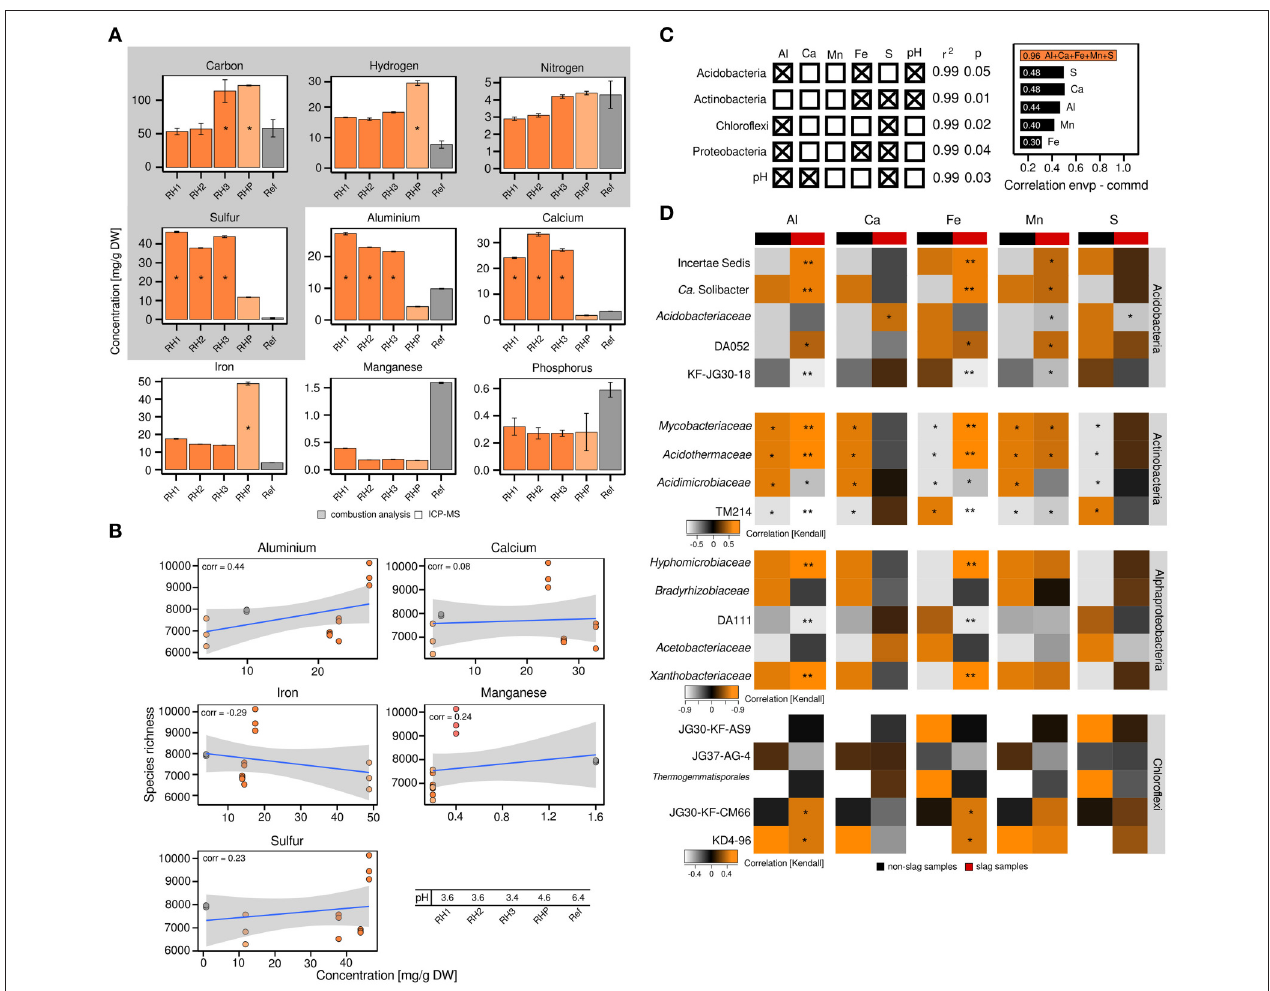
FIGURE 2 | Correlation analyses between the abundance of particular bacterial taxa and elements. Detection and quantitation of the examined elements involved combustion analysis and inductively coupled plasma mass spectrometry, *significant enrichment ( p ≤ 0.05) based on one-way ANOVA, DW = dry weight (A) . Correlation analysis between bacterial species richness and particular elements based on Pearson correlation coefficients (corr = correlation) (B) . Multiple regression analysis based on log-transformed elemental data (left) and correlations between either individual environmental parameters or the complete set of all five environmental parameters and bacterial community structure as determined by relating the environmental parameters to determined Jensen-Shannon divergences (right; envp = environmental parameter, commd = community dissimilarity) (C) . Kendall’s tau coefficients were calculated to link the occurrence of specific taxa within phyla of interest to selected environmental parameters. Determined p -values were corrected for multiple comparisons (Benjamini and Hochberg, 1995). Asteriks indicate * p ≤ 0.05 and ** p ≤ 0.01 (D)